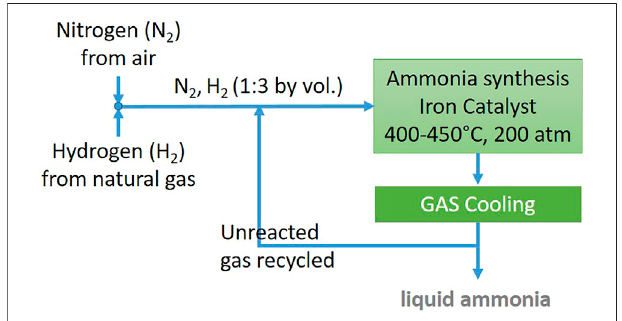
FIGURE 1 | Scheme of a typical Haber – Bosch